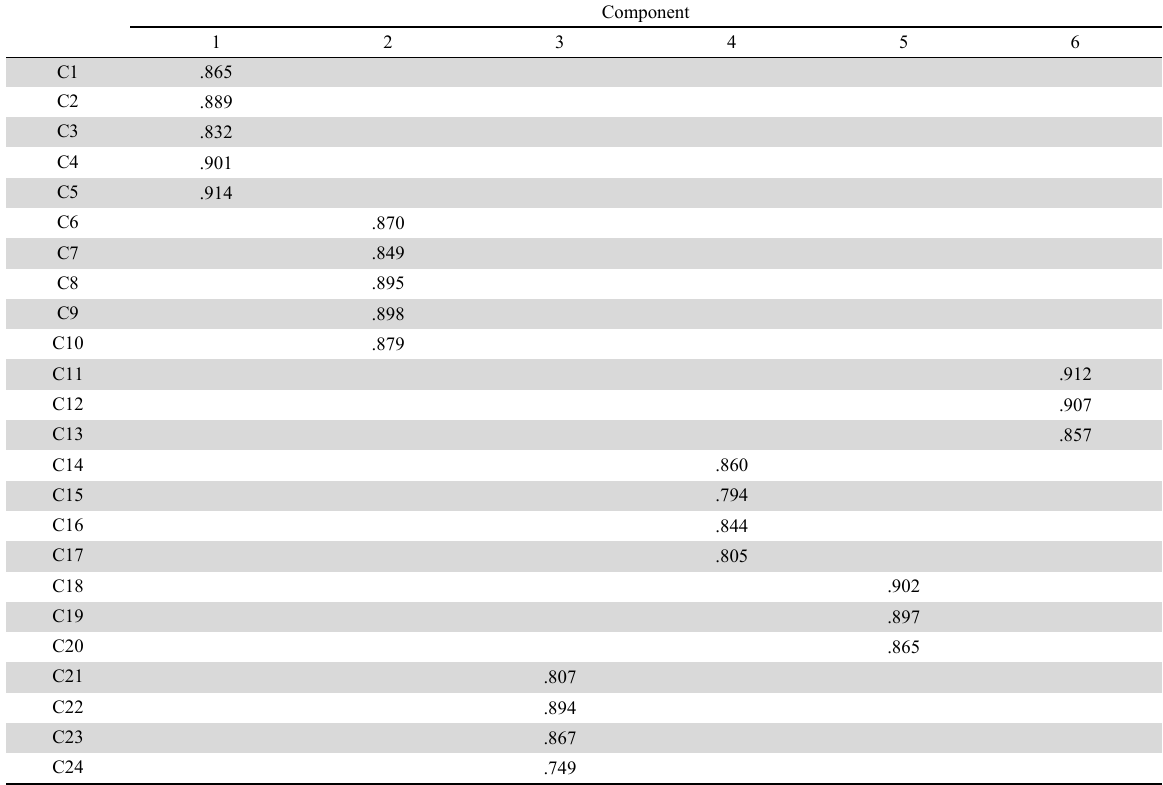
Pattern Matrix (Principal Component Analysis after Promax